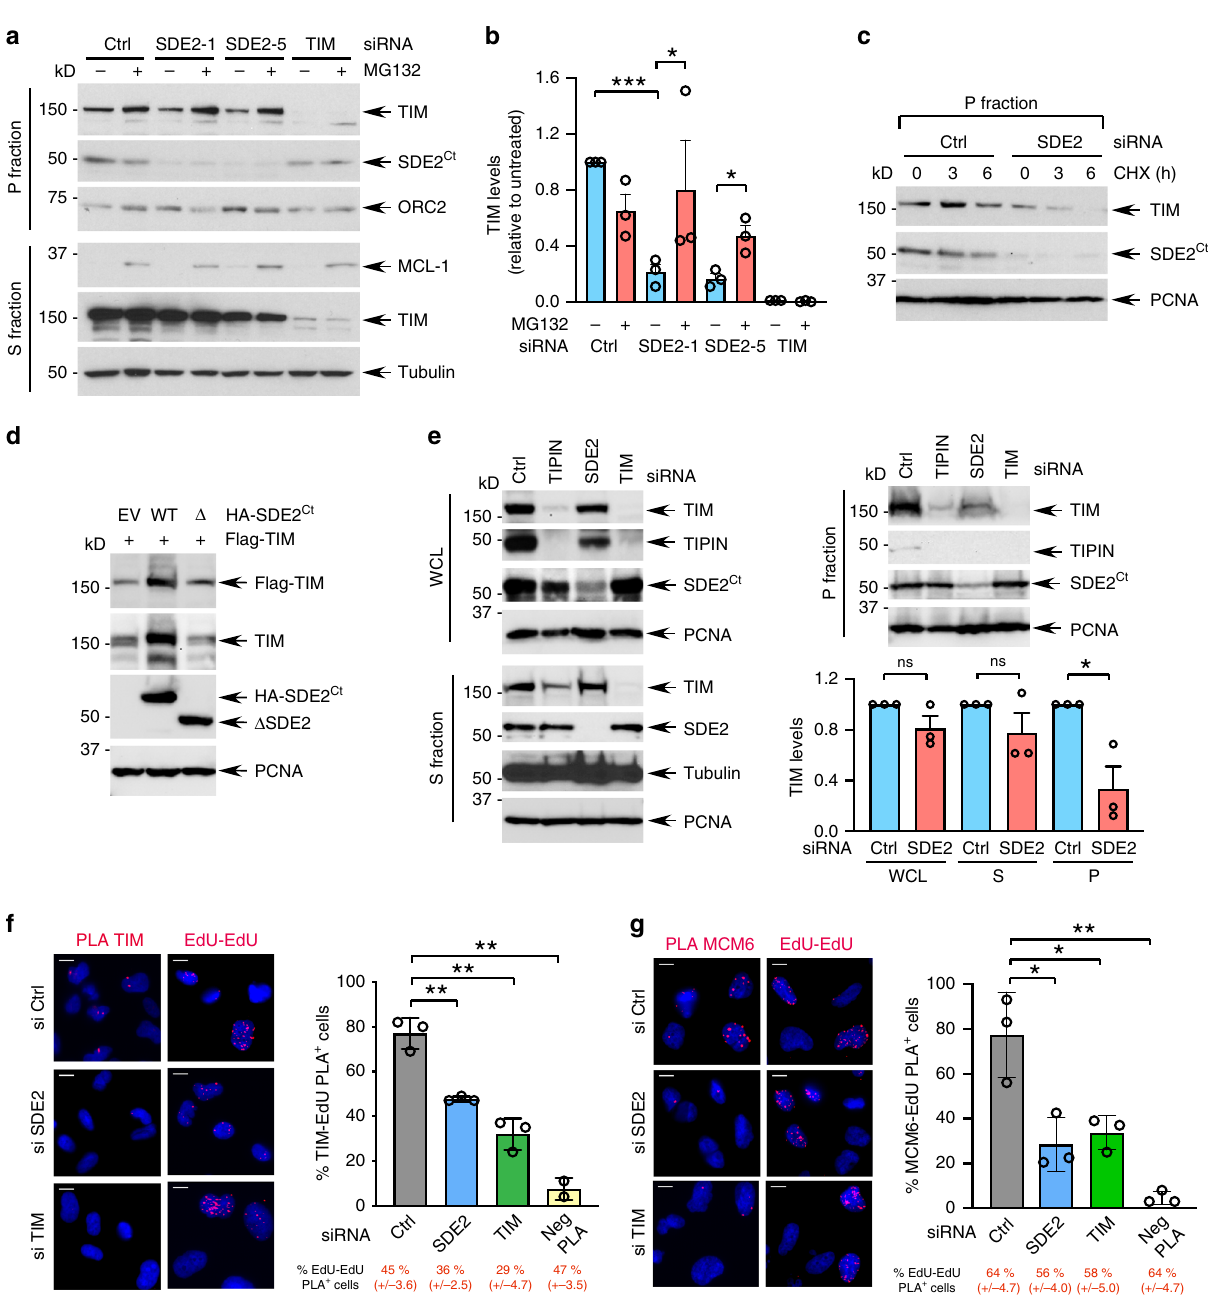
Fig. 3 SDE2 promotes the stability and localization of TIM at replication forks. a Endogenous TIM levels in S and P fractions with SDE2 depleted. U2OS cells transfected with the indicated siRNAs were fractionated into S and P fractions and analyzed by WB. Where indicated, cells were treated with 20 μ M MG132 for 6 h before harvest. b Quanti fi cation of TIM levels in the P fraction ( n = 3 biologically independent experiments, mean ± SEM, * P < 0.05, Student ’ s t -test). c Degradation of TIM in the P fraction. siRNA-transfected U2OS cells were treated with 100 μ g/mL cycloheximide (CHX) for the indicated times, and the P fraction was analyzed by WB. d WB analysis of 293T cells co-transfected with Flag-TIM and either HA-SDE2 Ct WT or Δ SDE2 mutant. e WB analysis of whole-cell lysate (WCL), S, and P fractions derived from U2OS cells transfected with the indicated siRNAs. TIM levels in each fraction were quanti fi ed ( n = 3 biologically independent experiments, mean ± SEM, * P < 0.05, Student ’ s t -test, ns, not signi fi cant). Data were normalized to the corresponding percentage of EdU-EdU PLA-positive cells. f Left: TIM:EdU PLA from U2OS cells transfected with the indicated siRNAs. Scale bar, 10 μ m. Right: quanti fi cation of cells positive for TIM:EdU PLA foci out of EdU + cells (>300 cells per condition, n = 3 biologically independent experiments, mean ± SD, ** P < 0.01, Student ’ s t -test). Neg PLA indicates the omission of the Biotin antibody. g Left: MCM6:EdU PLA foci from U2OS cells transfected with the indicated siRNAs. Scale bar, 10 μ m. Right: quanti fi cation of cells positive for MCM6:EdU PLA foci out of EdU + cells (>300 cells per condition, n = 3 biologically independent experiments, mean ± SD, ** P < 0.01, * P < 0.05, Student ’ s t -test). Data were normalized to the corresponding percentage of EdU- EdU PLA-positive